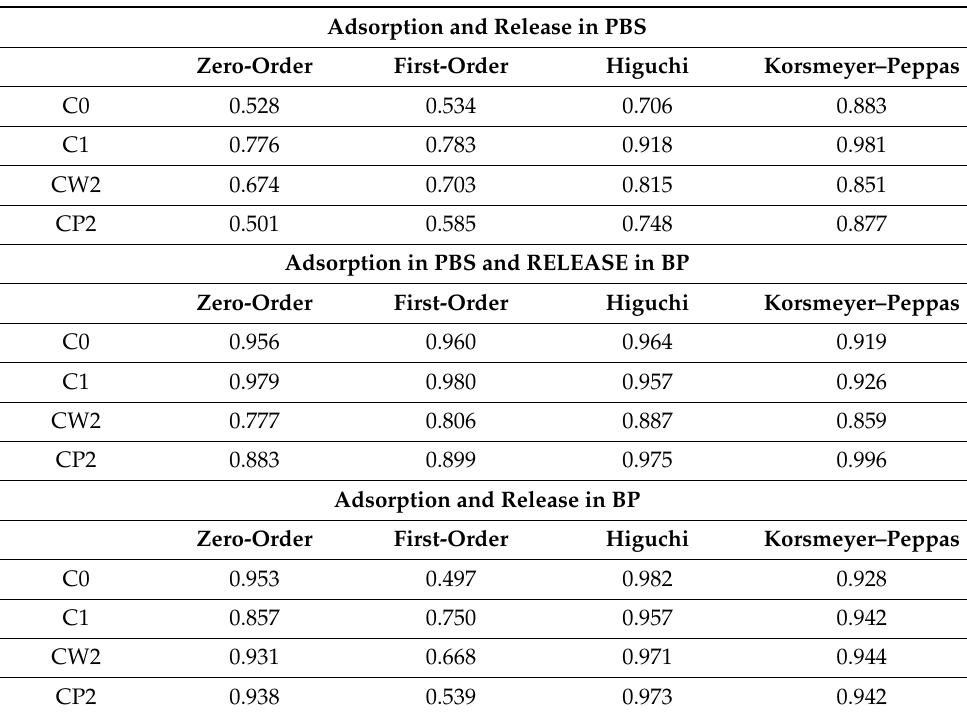
Table 3. The values of r 2 for different kinetics models of SRL release from